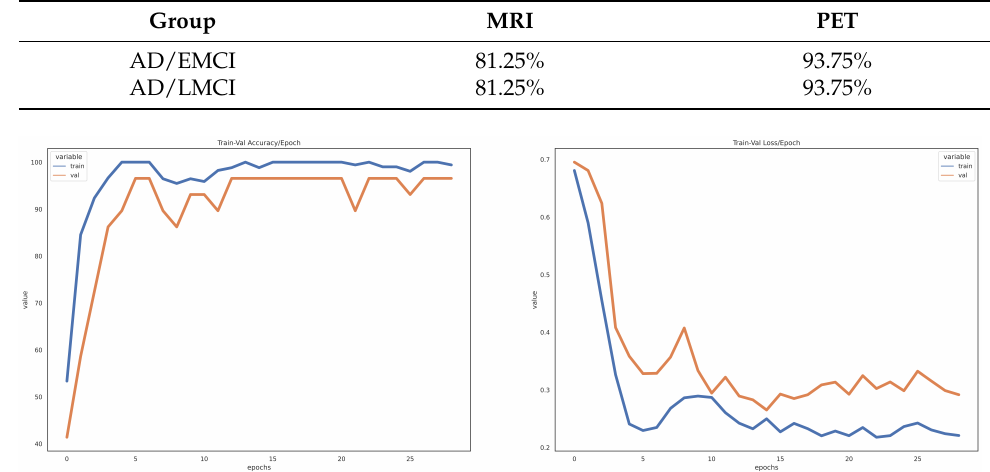
Table 3. Accuracy of the proposed model on test data.